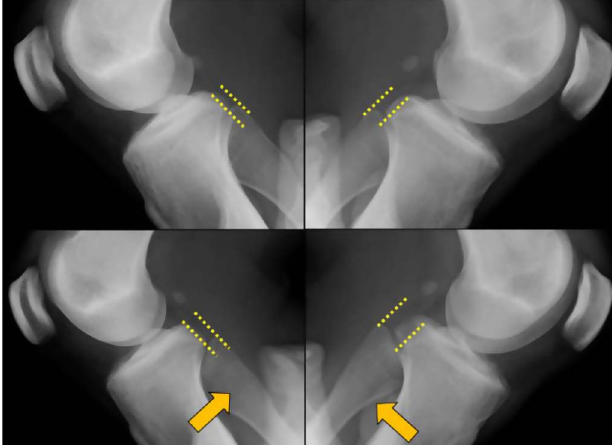
Figure 2. Anteroposterior stress X-ray imaging of the tibio fi bular joint. Difference between the right and left sides are seen on anteroposterior stress X-ray images of the tibio fi bular joint.